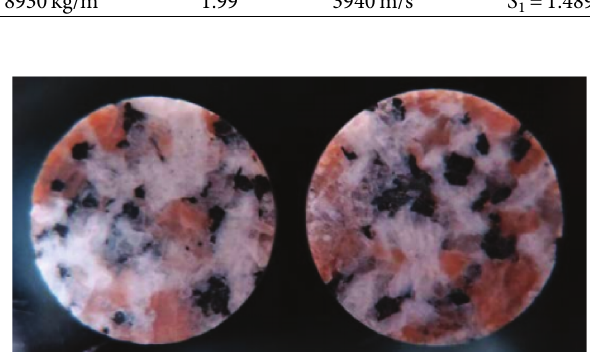
Figure 5: Granite specimen used in plate impact experiment of Li et al. [7]. Table 3: Nominal mineral composition of the Wulian granite [7]. Mineral Wt. %